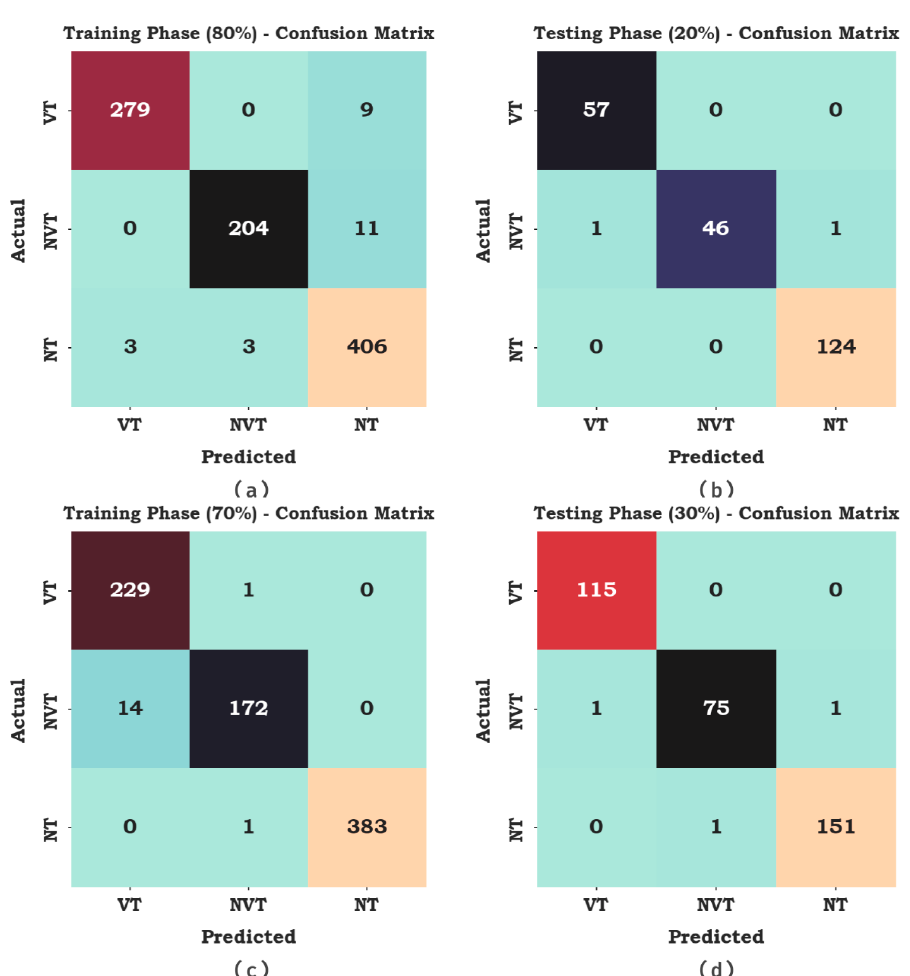
Figure 10. Confusion matrices of AAOXAI-CD system on dataset-2 ( a , b ) TRS/TSS of 80:20 and ( c , d ) TRS/TSS of 70:30.